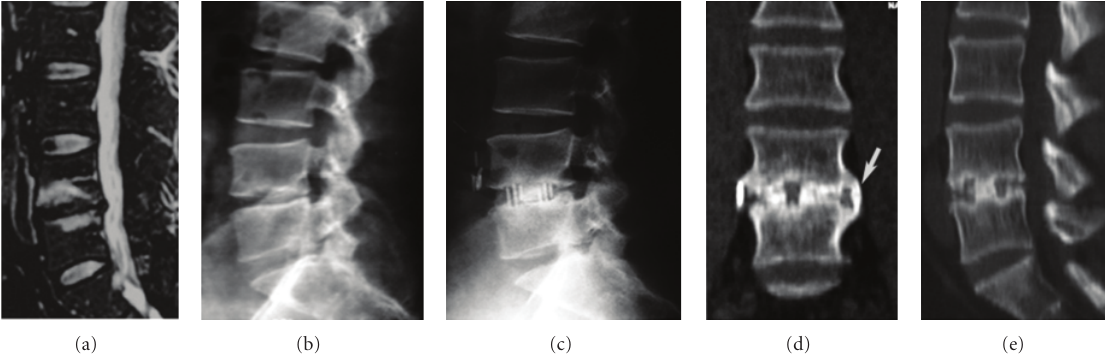
Figure 2: Case example number 1. Male, 54 years old, 7-year pain history which used to get worst by end of the day, refractory to physiotherapy and chiropractic. VAS scores-preoperative 8; 1-week 2; 24-month 1. Patient underwent an L4L5 stand-alone lateral interbody fusion. (a) Preoperative sagittal MRI. (b) Preoperative lateral orthostatic X-ray. (c) 24-month lateral orthostatic X-ray. (d) 24-month computed tomography coronal reconstruction, arrow shows fusion sentinel sign. (e) 24-month computed tomography sagittal reconstruc- tion.